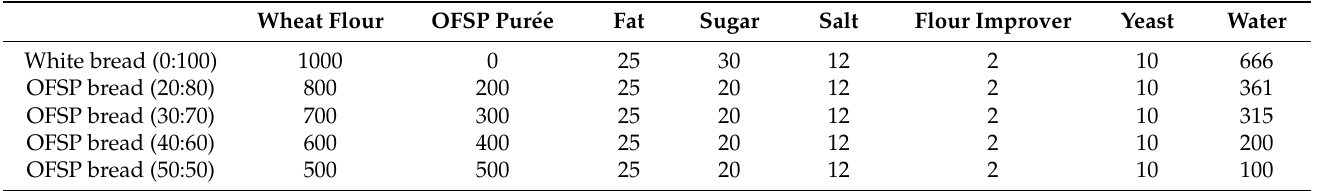
Table 1. Ingredient formulation for wheat flour–OFSP pur é e composite bread (g/kg). Wheat